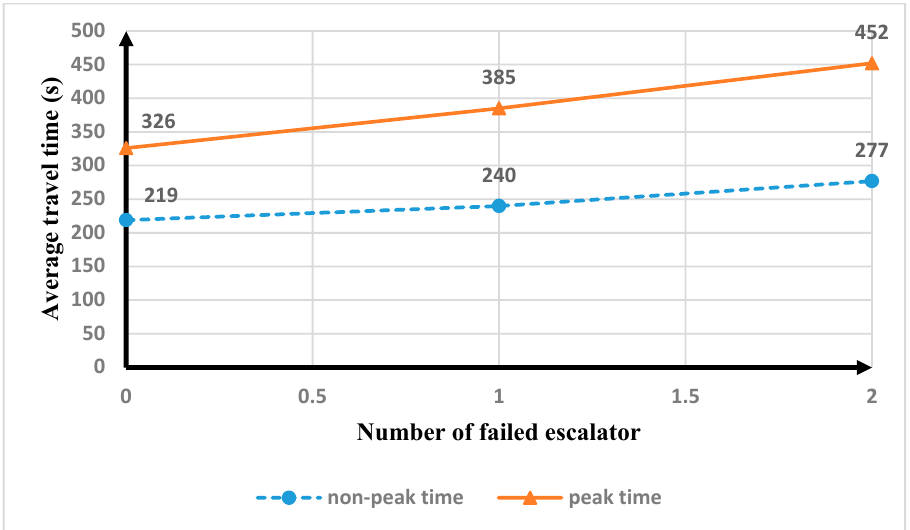
Figure 8. The impact of the number of failed gates on average travel time. ( a ) The impact of the number of failed inbound gates on average travel time; ( b ) The impact of the number of failed outbound gates on average travel time.